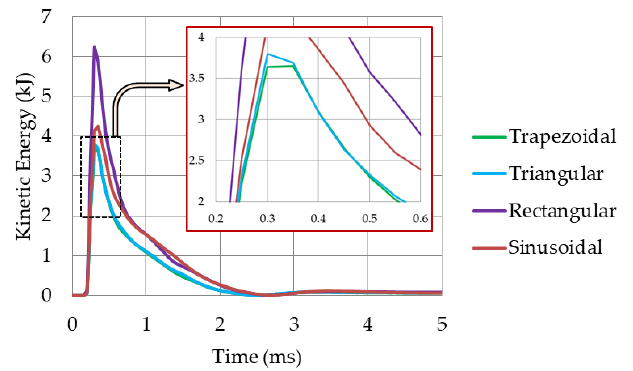
Figure 12. The effect of corrugation shape/topology on the kinetic energy of the sandwich panel, when subjected to 0.5 kg of TNT at R = 0.5 m (BI-5).